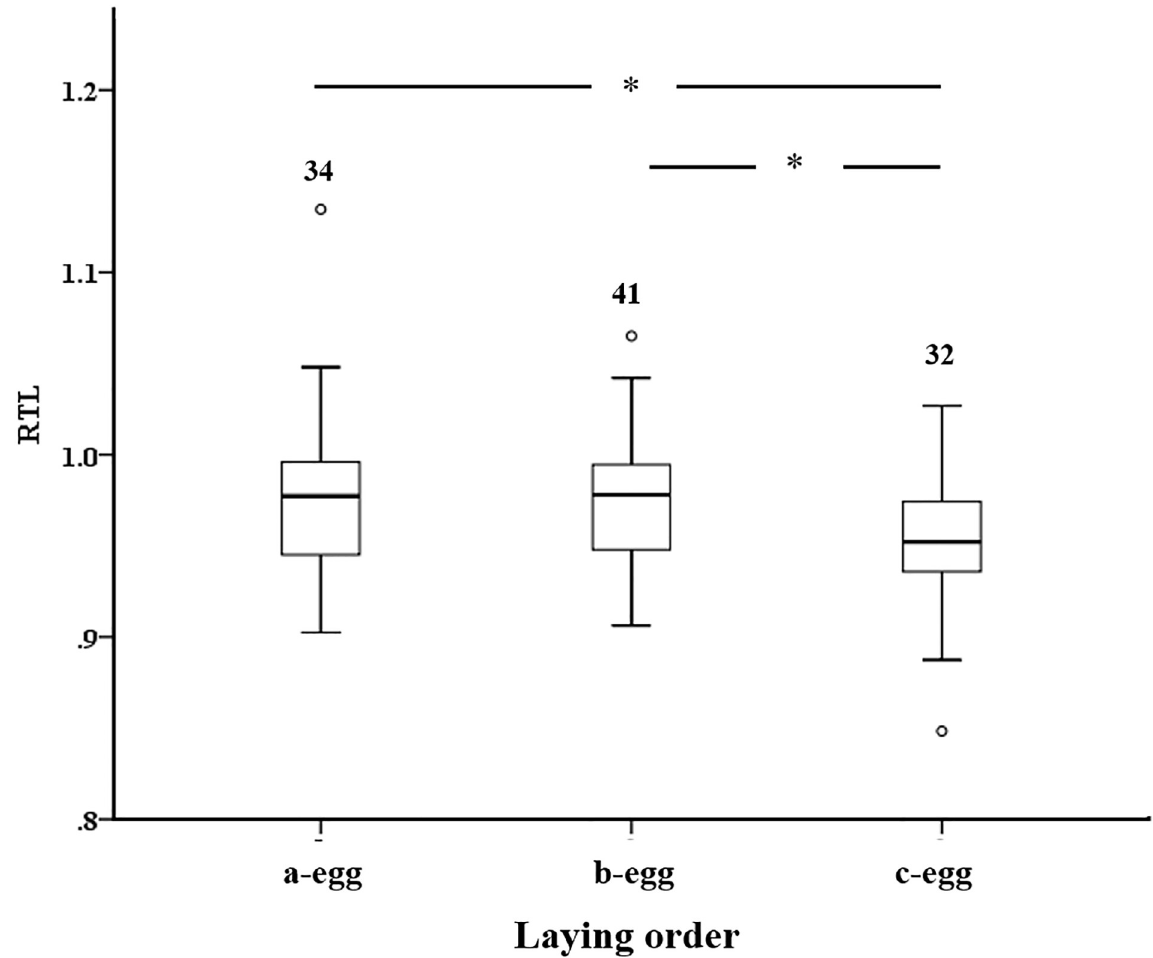
Fig 1. Relative telomere length at hatchling according to laying order. The number of hatchlings per each position in the laying sequence is reported.